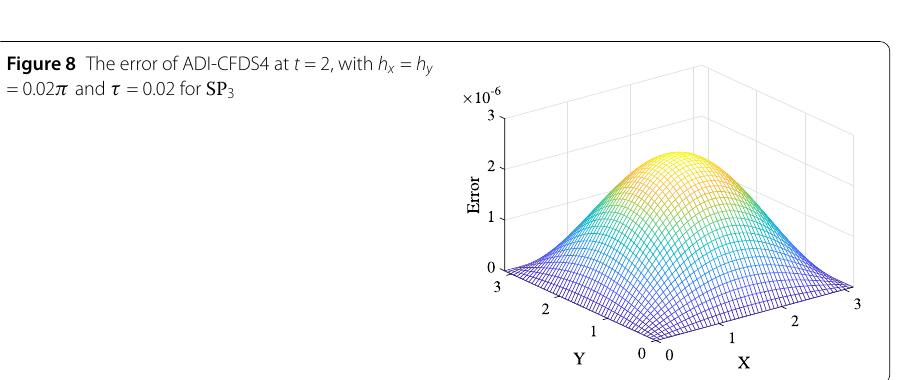
Figure 7 The figures of solutions of R-ADI-CFDS4(left) and difference(right) between R-ADI-CFDS4 and ADI-CFDS4 at t = 4, with h x = h y = 0.02 π and τ = 0.02 for SP 3